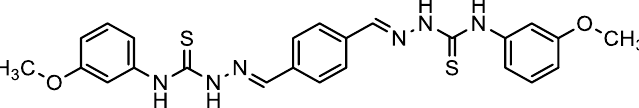
Figure 1. The chemical structure of PMBMH.